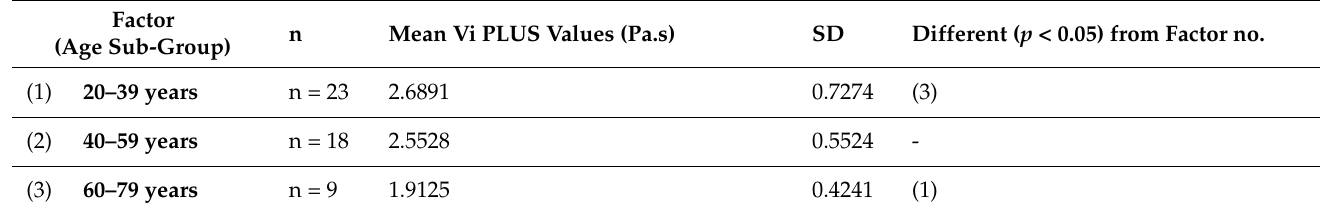
Figure 5. Box-and-whisker distribution plots showing Vi PLUS values across three different age subgroups. Vi PLUS values decreased slightly with age progression. We also found a positive correlation between the mean measurement depths and the 2D-SWE PLUS values (r = −0.3776, p = 0.0075), as well as with the Vi PLUS measurements (r= −0.4642, p = 0.0008). The method found good intra-operator reproducibility for the 2D- SWE PLUS measurements, with an ICC of 0.8365 and a 95% CI of 0.7512 to 0.8990, and for Vi PLUS, with an ICC of 0.9 and a 95% CI of 0.8515 to 0.9397. We discovered that eGFR, the median measurement depths, the median viscosity, and age influenced the 2D-SWE PLUS and Vi PLUS values in the univariate regression, but when they were included in the multivariate analysis, no statistically significant model was found. 4. Discussion